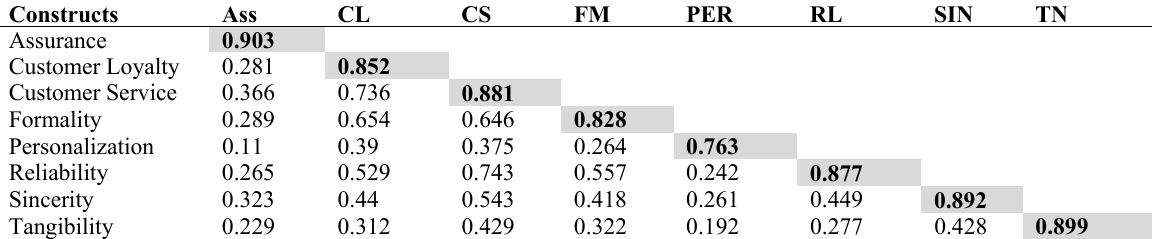
Discriminant validity of Measurement